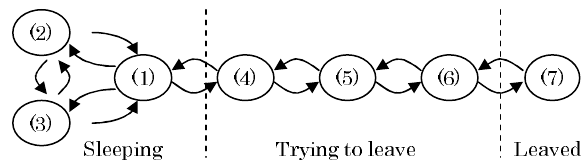
Figure 6. Status transition in respective behavior